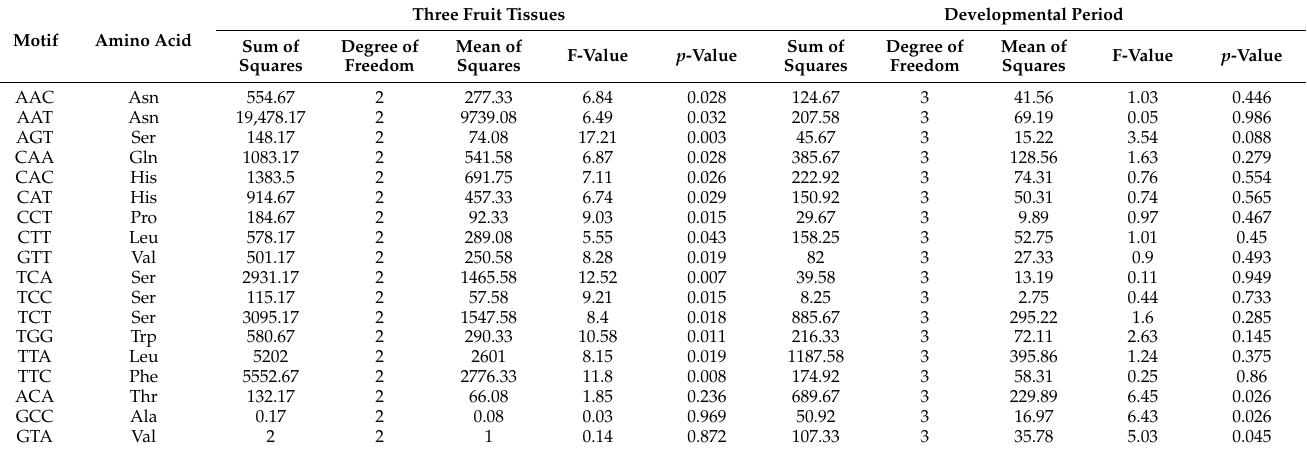
Table 2. Analysis of variance for TNRs in different fruit tissues and developmental